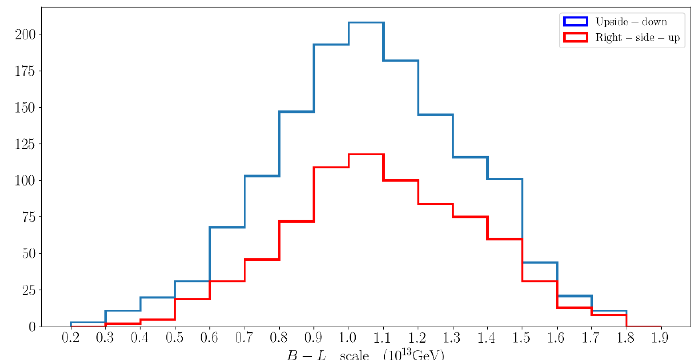
Figure 4. Plot of the U(1) B (cid:0) L breaking scale for the 1406 valid black points shown in (cid:12)gure 3. The B - L and supersymmetry breaking scales are computed using the formalism presented in [30]. We indicate what fraction of each bin consists of those cases in which M BL > M SUSY (right-side-up), and in which M BL < M SUSY (upside-down). For example, between 1.0 and 1.1 (cid:2) 10 13 GeV the number of right-side-up valid points is (cid:25) 120 whereas the number of upside-down valid points is (cid:25) 210 (cid:0) 120 =